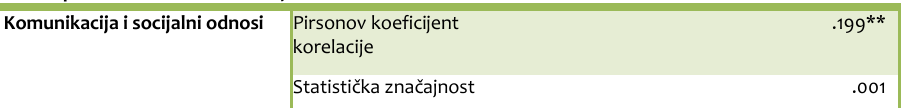
Tabela 1. Izvod iz matrice korelacije između komunikacije i pozitivnog odnosa prema sa držajima o